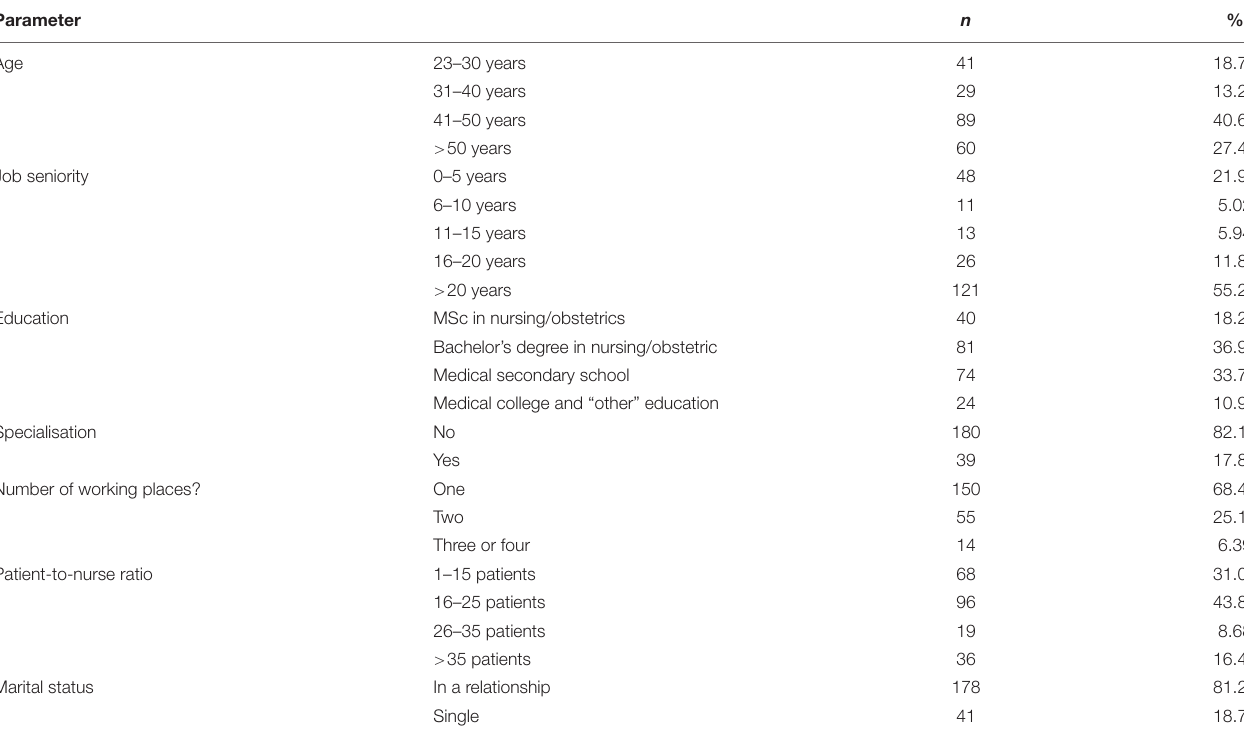
TABLE 1 | Characteristics of study participants ( n =